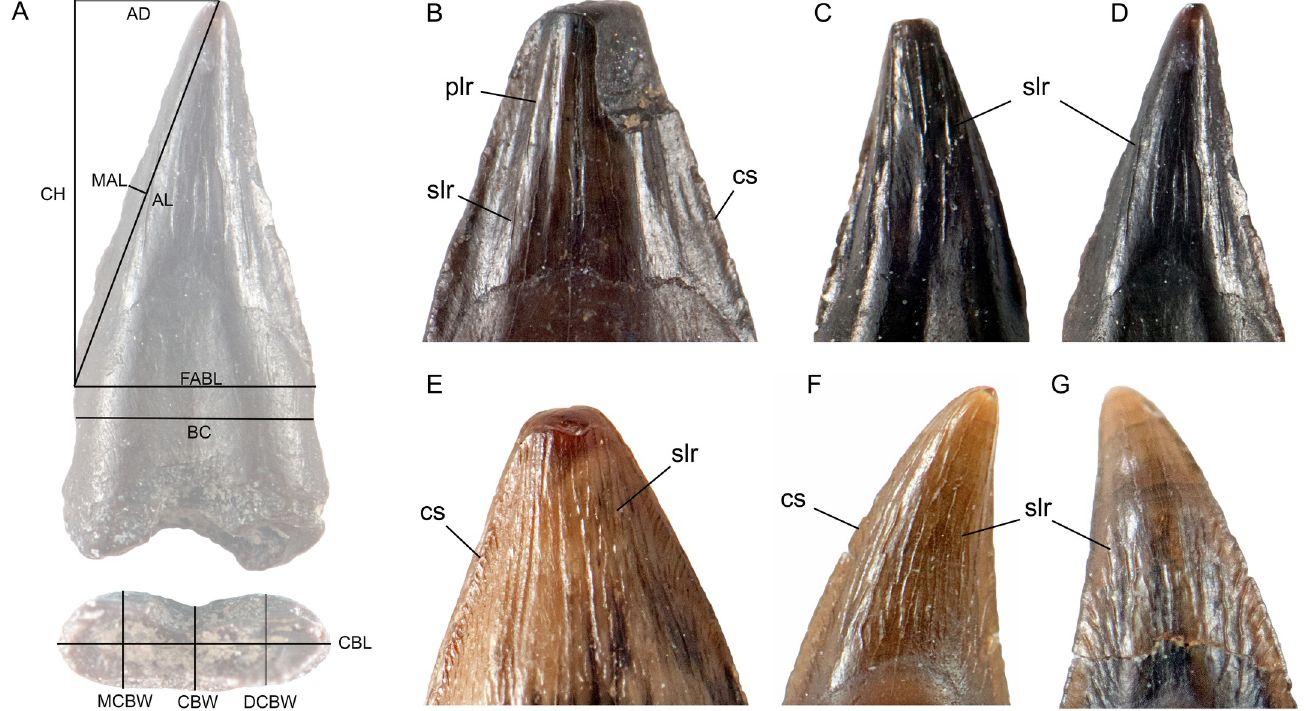
Fig 1. Tooth measurements and details of surface features on the crowns of putative avian and crocodilian teeth. A , isolated “bird” tooth (TMP 1995.184.20C) with tooth measurements superimposed. Lateral view: AD (apical distance), CH (crown height), MAL (mesial-apical distance), AL (apical length), FABL (fore-aft basal length), BC (basal constriction). Basal view: CBL (crown basal length), CBW (crown basal width), MCBW (mesial crown basal width), DCBW (distal crown basal width). B , TMP 1999.24.152 (morphotype 1); C , UALVP 852–4 (Morphotype 2); D , TMP 1995.184.20C (Morphotype 2); E , UALVP 54359A (fossil crocodilian); F , G , lingual and labial views of uncatalogued C (Morphotype 3). Abbreviations: cs, carinal striae; plr, primary longitudinal ridges; slr, secondary longitudinal ridges. Images not to